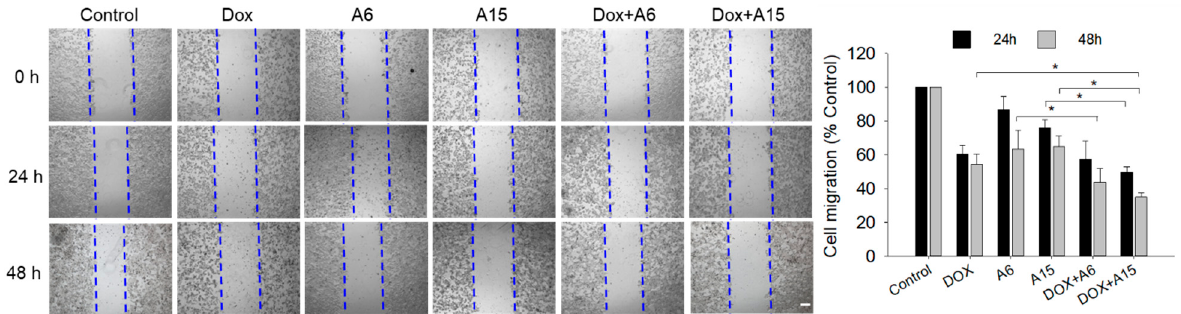
Figure 13. Synergistic effects of the combination treatment of doxorubicin (DOX) with A6 or A15 on the migration of SK-BR-3 cells. Cells were exposed to A6 (12.5 μ M), A15 (12.5 μ M), DOX (0.125 μ M), or their combinations for 24 or 48 h, as indicated. Control cells were treated with serum-free media containing 0.025% DMSO instead. Alterations in cell migration were measured at 24 and 48 h by wound healing assay, as described in the Materials and Methods. Representative images are shown. Data are displayed as mean ± SEM from three independent experiments. * p < 0.05. Scale bar, 250 μ m.